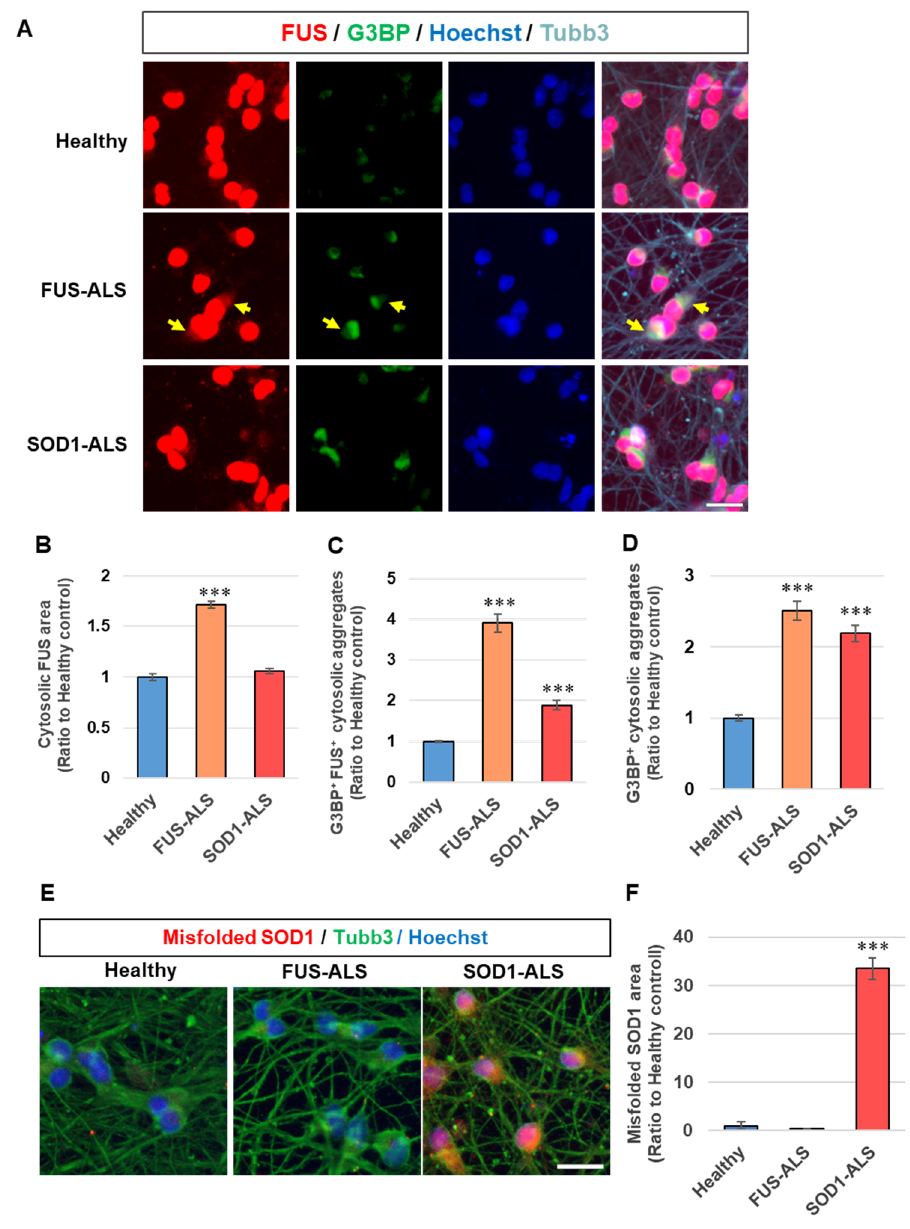
Figure 2. Evaluation of protein accumulation in the ALS neurons. ( A ) Representative images of iPSC-derived motor neurons immunostained for G3BP (green), FUS (red), Tubb3 (cyan) and Hoechst 33342 (blue) on day 14. Yellow arrowheads indicate the cytosolic FUS+ region. The scale bar represents 50 µ m. Quantification of: ( B ) cytosolic FUS+ area; ( C ) FUS + G3BP+ cytosolic aggregates; and ( D ) G3BP+ cytosolic aggregates per cell. Each readout of FUS -ALS and SOD1 -ALS neurons was normalized to that of the healthy control ( n = 6, mean ± SEM). ( E ) Representative image of iPSC-derived motor neurons immunostained for Tubb3 (green), misfolded SOD1 (red), and Hoechst 33342 (blue) on day 14. The scale bar represents 50 µ m. ( F ) Quantification of misfolded SOD1 area per cell. The misfolded SOD1 area of FUS- and SOD1 -ALS neurons was normalized to that of the healthy control ( n = 6, mean ± SEM). ***: p < 0.001 vs. healthy control ( t -test).